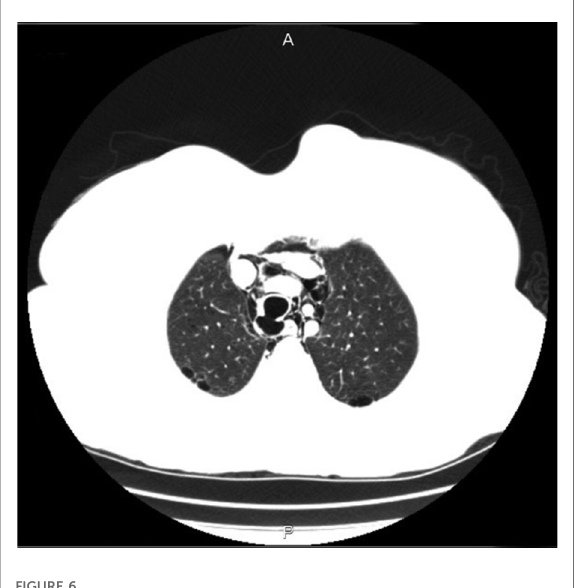
FIGURE 6 Computed tomography image of level IIIA PITL.